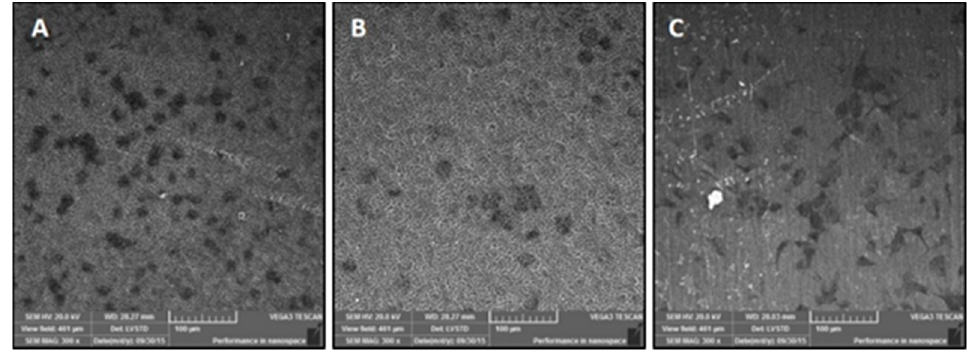
Figure 4. SEM micrographs demonstrating differential cell spreading patterns, via extracellular matrix aggregates, between aligned TiNT ( A ) and trabecular TiNT ( B ) versus control ( C ) surfaces at 3-day attachment timepoint.